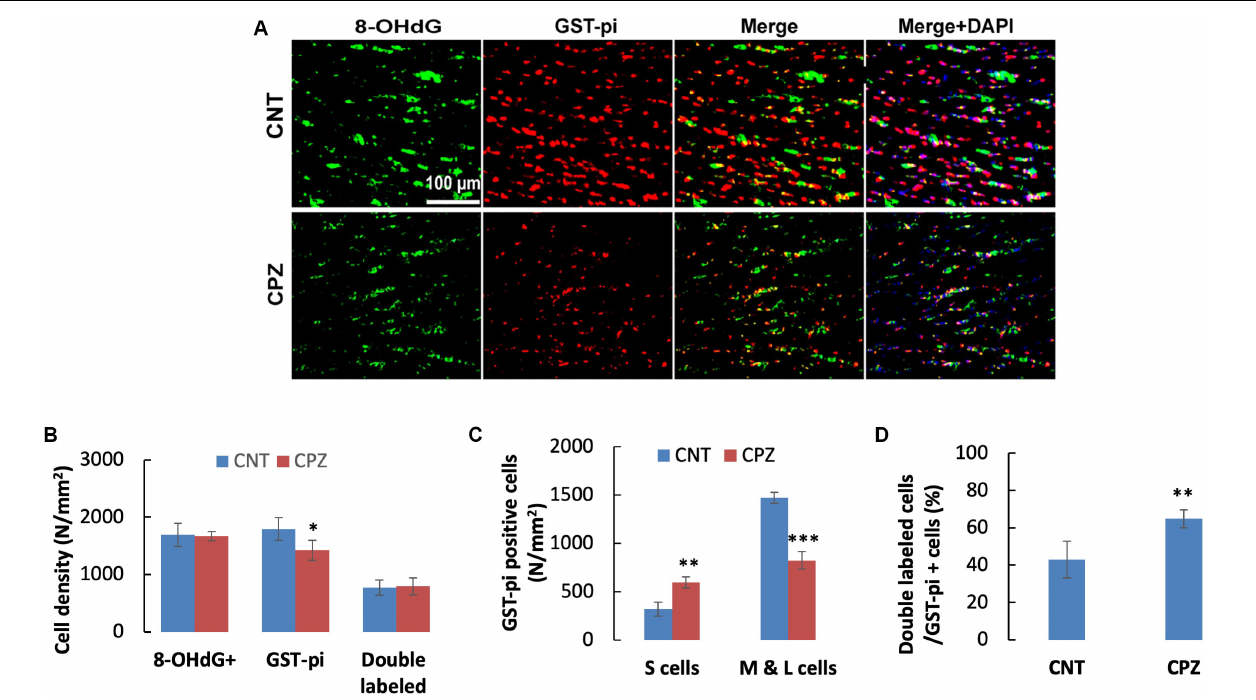
FIGURE 2 | (A) Representative photographs showing cells labeled by the antibody to 8-OHdG, antibody to GST-pi, and double labeled cells by the two antibodies. (B–D) Bar charts showing the statistical analysis results of the immunofluorescent staining. Data are expressed as means ± SD ( n = 6/group). * p < 0.05, ** p < 0.01, *** p < 0.0001. The comparisons were made between CNT and CPZ groups by performing t-test or chi-square test (percentage of double labeled cells in GST-pi +